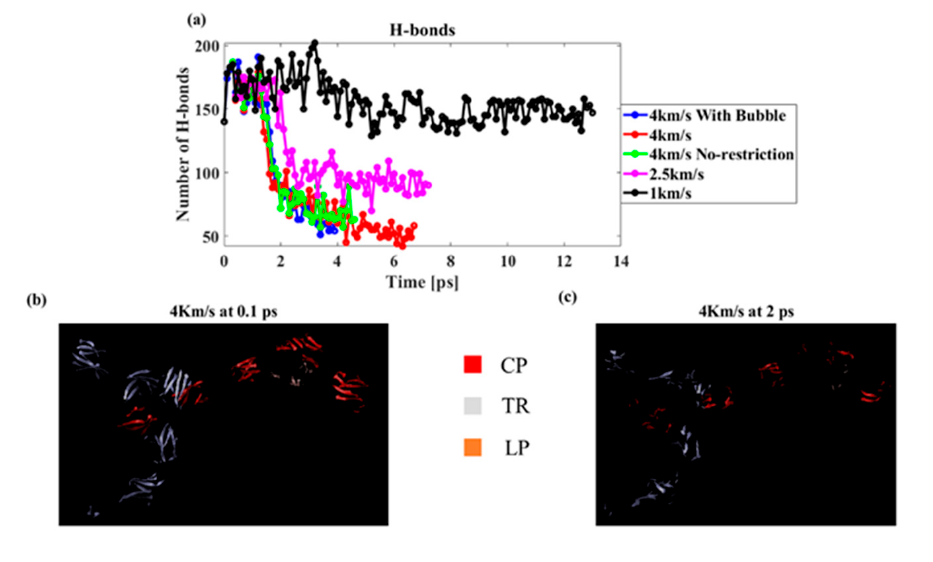
Figure 11. ( a ) Number of hydrogen bonds at different speeds and boundary conditions (cut-off distance 3 Å and angle 20 ◦ ), ( b ) Beta-sheet at the initial undeformed state, and ( c ) beta-sheet in the deformed state due to the shock wave.